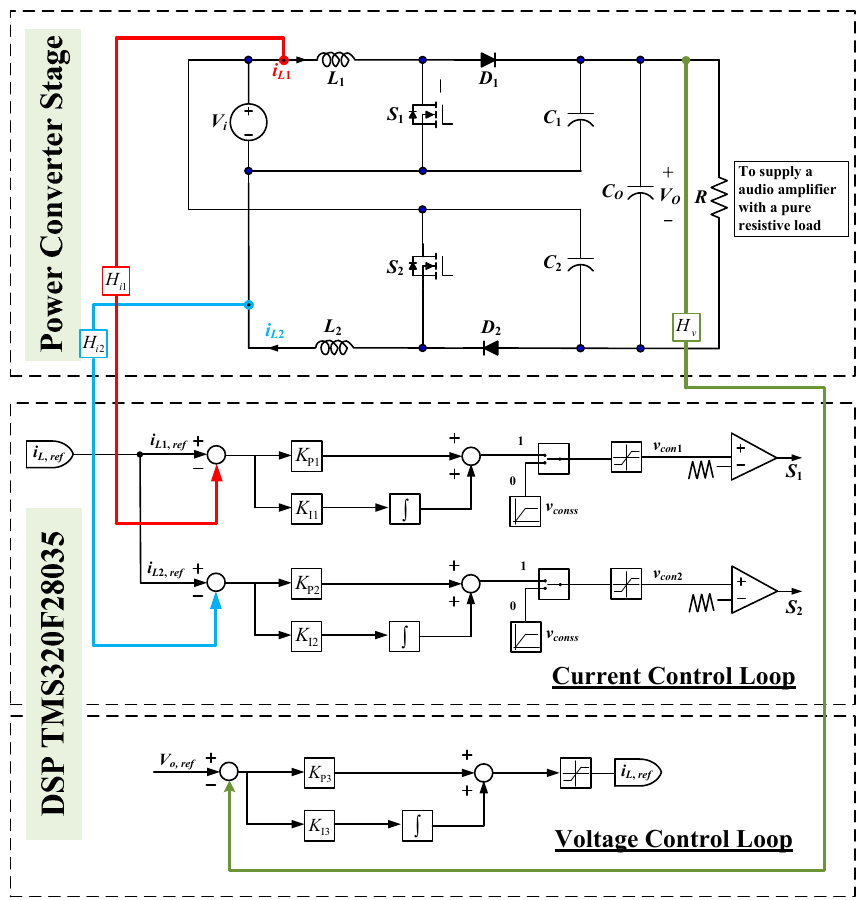
Figure 8. The developed control system for the combined boost converter.